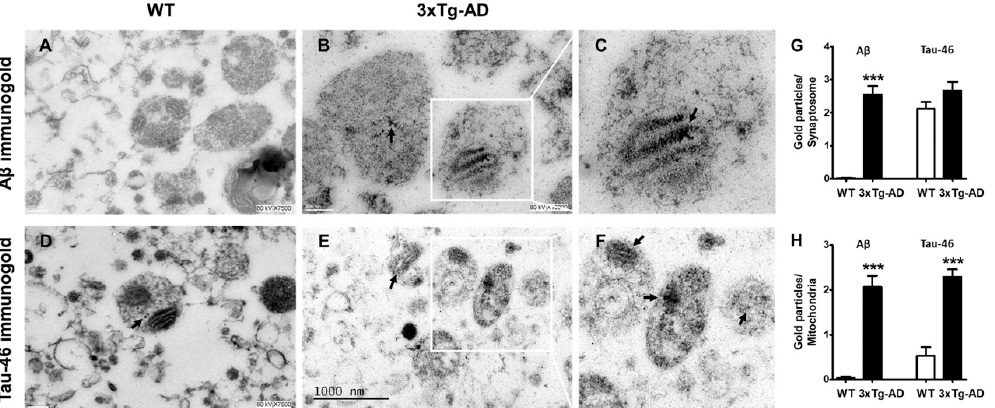
Figure 5. Increased accumulation of A β and tau in synaptosomes from middle-aged WT and 3xTg- AD mice. Representative immunogold electron microscopy images of A β 1-42 and tau labeled with a gold-conjugated antibody (12 nm size) demonstrating A β and tau accumulation (black arrows). Hippocampal synaptosomes from WT ( A , D ) and old female 3xTg-AD mice ( B , E ). ( C , F ) are magnifications of B , E . Quantification of immunogold particles is depicted ( G , H ). Student’s t test, *** p < 0.001.